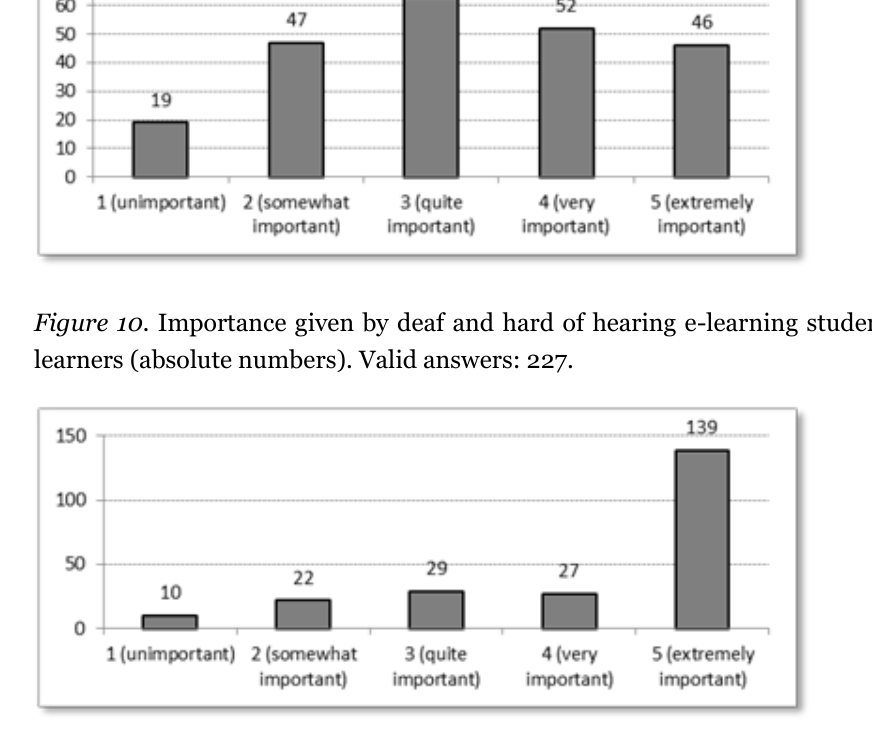
Figure 11. Importance given by deaf and hard of hearing e-learning students to accessibility of the course (absolute numbers). Valid answers: 227.